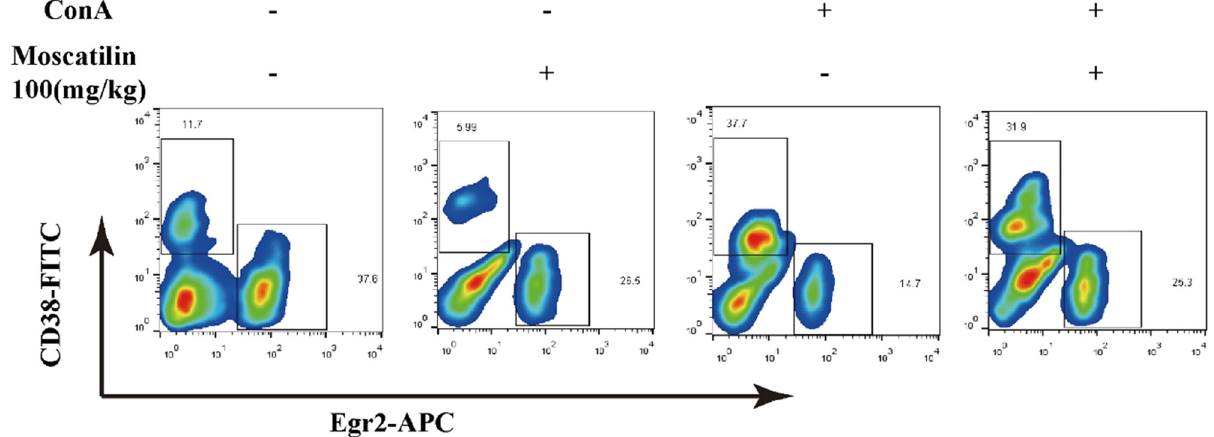
Figure A1: E ff ects of moscatilin on the M1/M2 macrophages. Macrophages in the liver tissues from the mice from di ff erent group at day 3 were gated in CD11b + cells by fl ow cytometry. Then M1 macrophages were characterized by CD38 + Egr2 − and M2 macrophages were characterized by CD38 - Egr2 + .